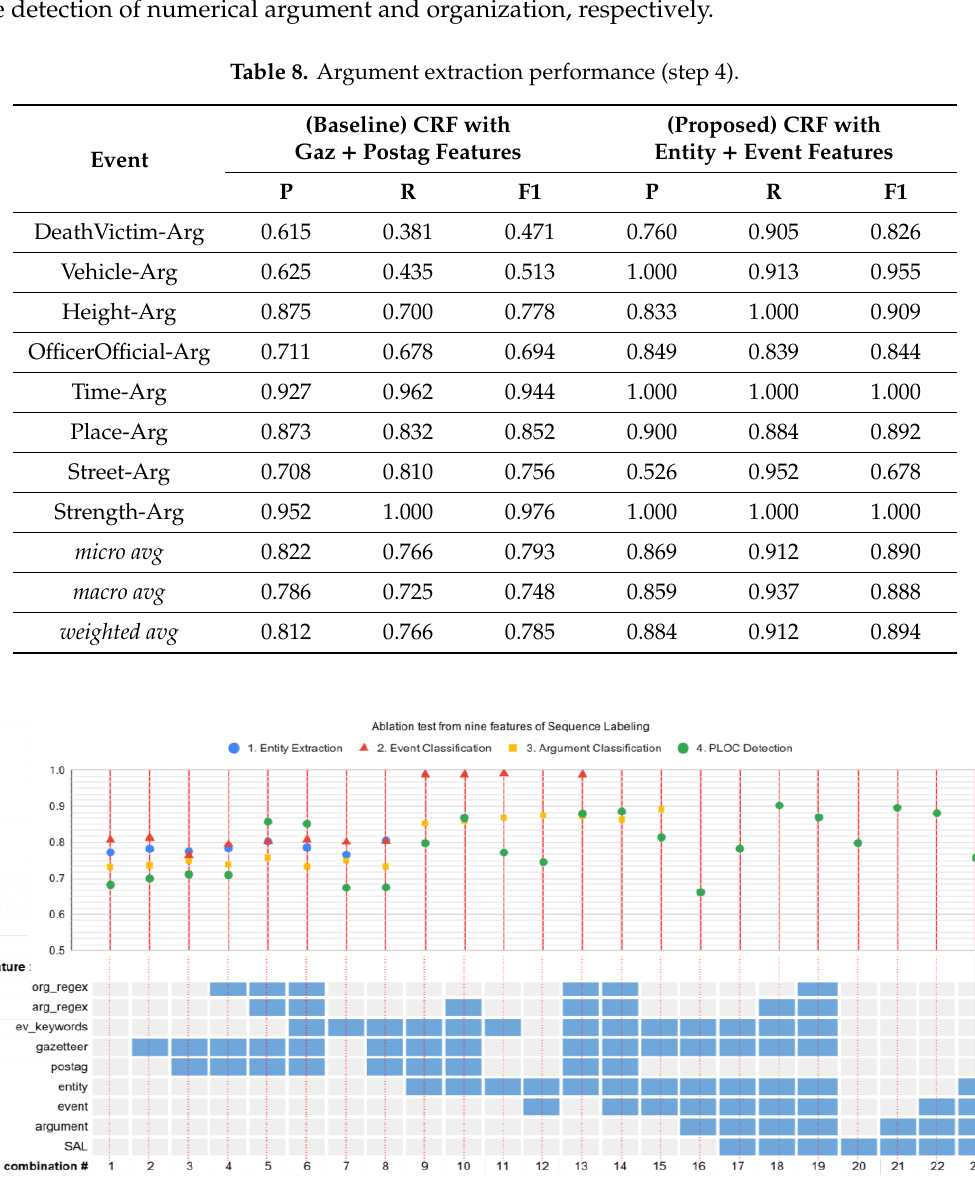
Figure 10. Ablation Test of weighted F1 score from nine combinations of features of four geotagging steps (step 1, 3, 4, and 5 from Figure 4). Active features are marked as blue cells (below part of the graphic). Missing score points means such combination of features is not applicable on that particular